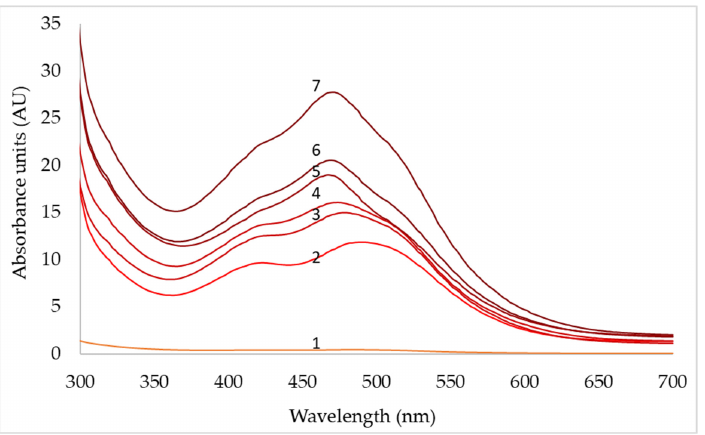
Figure 8. Absorbance scans of extracellular pigments (contained in the liquid broth) by spectro ‐ photometry produced from days 1–7 for the culture of T. albobiverticillius 30548 at 24 °C, pH 5, with pO 2 at 70%. Colored spectra indicates the production of pigments with respect to hues from day 1 to 7.